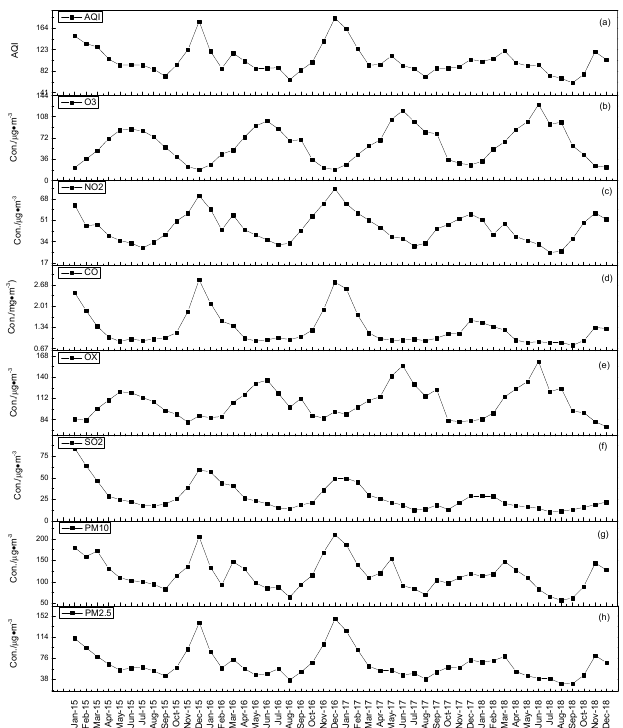
Figure 2. Average concentrations of air quality index (AQI) and six air pollutants concentrations in BTH area.